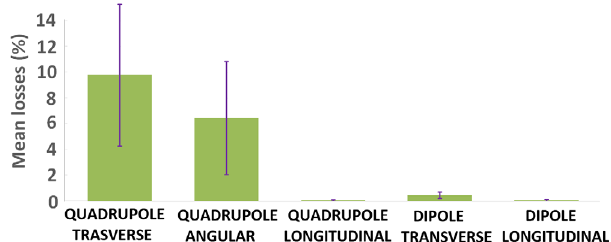
FIG. 7. Transverse profile of the beam in the bending (top) and nonbending (bottom) plane, assuming a misalignment of Q18 by 1 mm, as simulated for a 7 GeV =c beam in PTC, using the high- transmission optics. Losses occur mainly in the collimator and the quadrupole apertures for the bending plane, while, for the nonbending plane, in the bending magnets ’